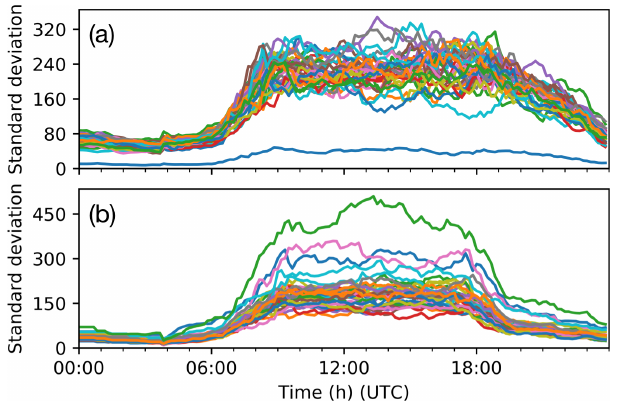
Figure 5. Standard deviation of LA (all boroughs of London, colours; for 44 weekdays preceded by weekdays) active occupancy levels (R4, Table 6) for (a) a N